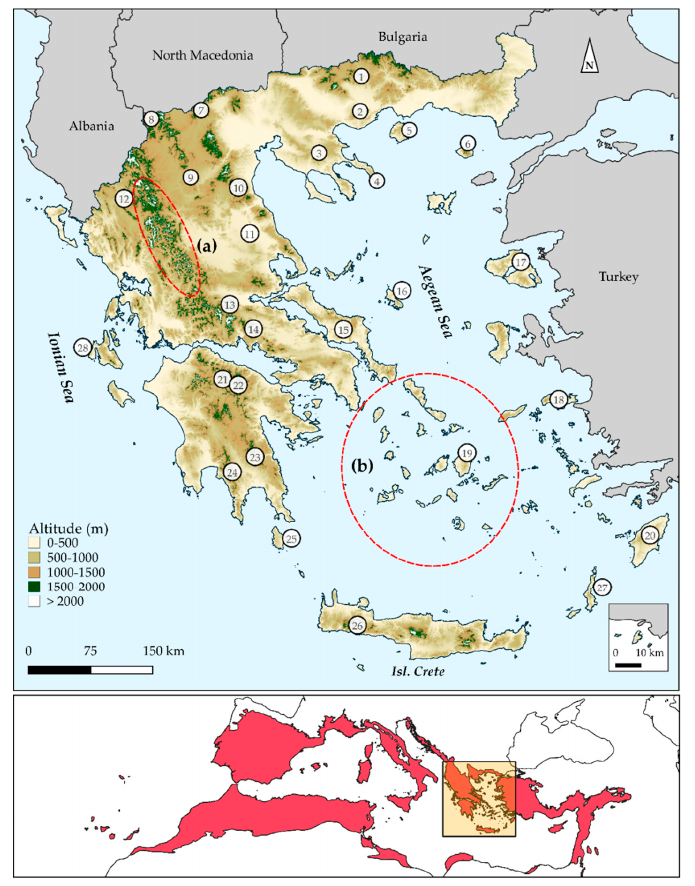
Figure 1. Upper panel: Map of Greece presenting major mountain massifs, as well as Aegean and Ionian islands that were identified as biodiversity hotspots and/or endemism centres and mentioned in the text. 1: Mt Falakron, 2: Mt Pangeon, 3: Chalkidiki mountains, 4: Mt Athos, 5: Isl.